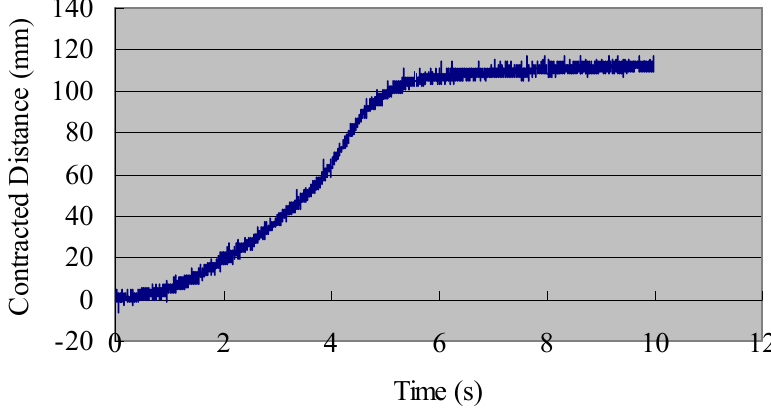
Figure 10. Deformation of the SMA actuator (30 g, 3 V).